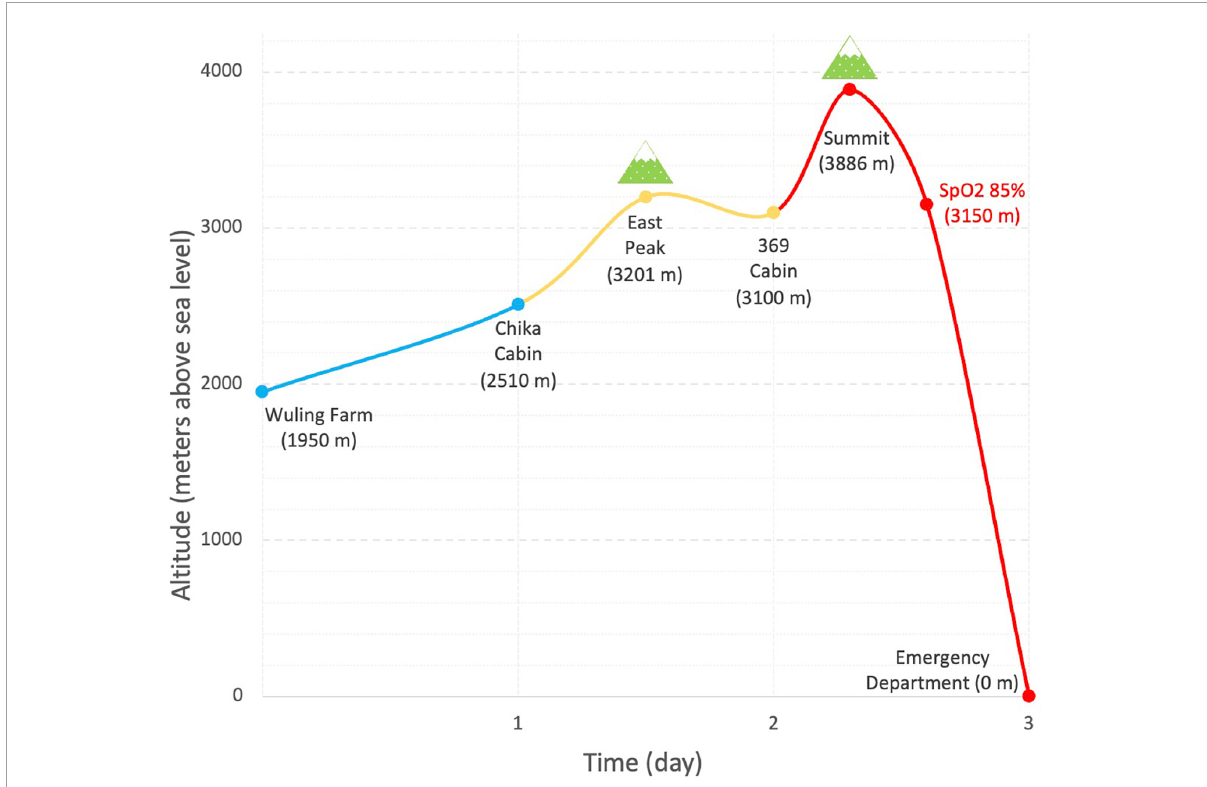
FIGURE1 Ascent profile and time of climbing Snow Mountain (Xueshan). Blue, yellow, and red curves denote the ascent on the first, second day, and third days, respectively.